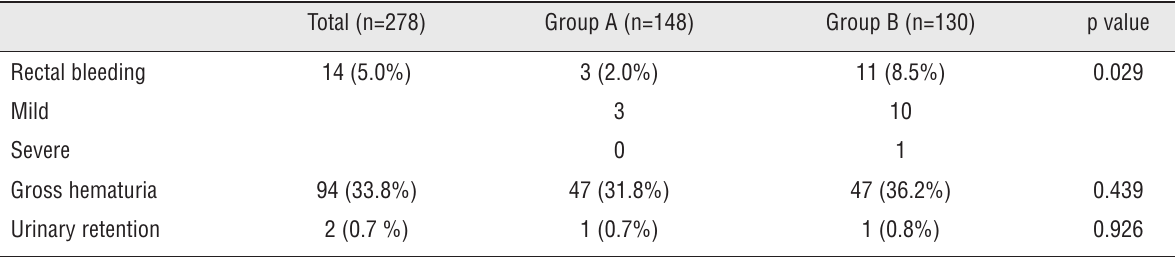
Table 2 - Frequency of main complications after the prostate biopsy.